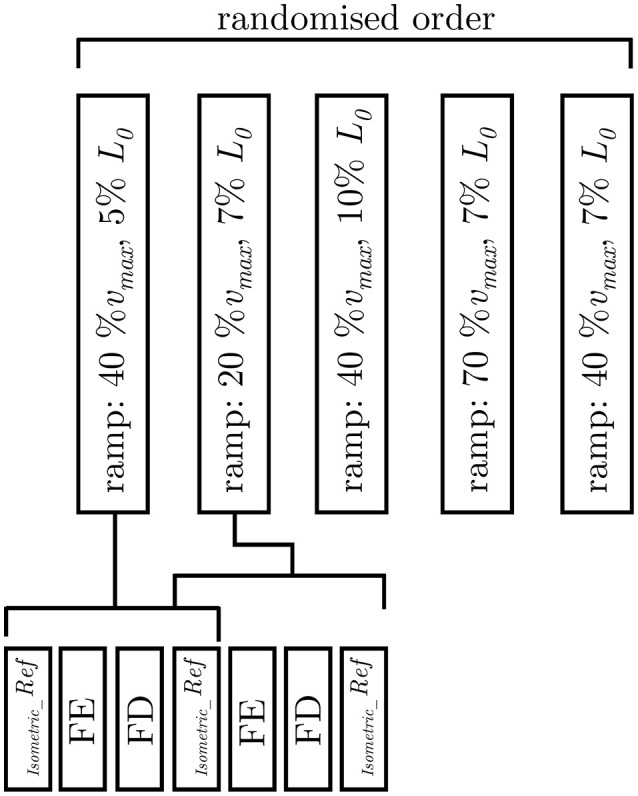
Experimental protocol. Examination of varying ramp parameters followed a pseudorandomised block design (upper trace). The applied ramp-velocity and ramp-length are normalized to the maximum shortening velocity (νmax) and optimum muscle length (L0), respectively. The lower trace illustrates the fixed protocol of muscle contractions consisting of isokinetic ramp experiments (FE: force enhancement, FD: force depression), and isometric reference contractions (Isometric_Ref).